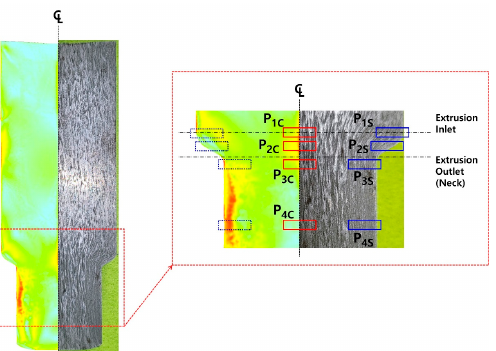
Figure 19. Measuring sections for EBSD analysis of cold forward-extruded preform.